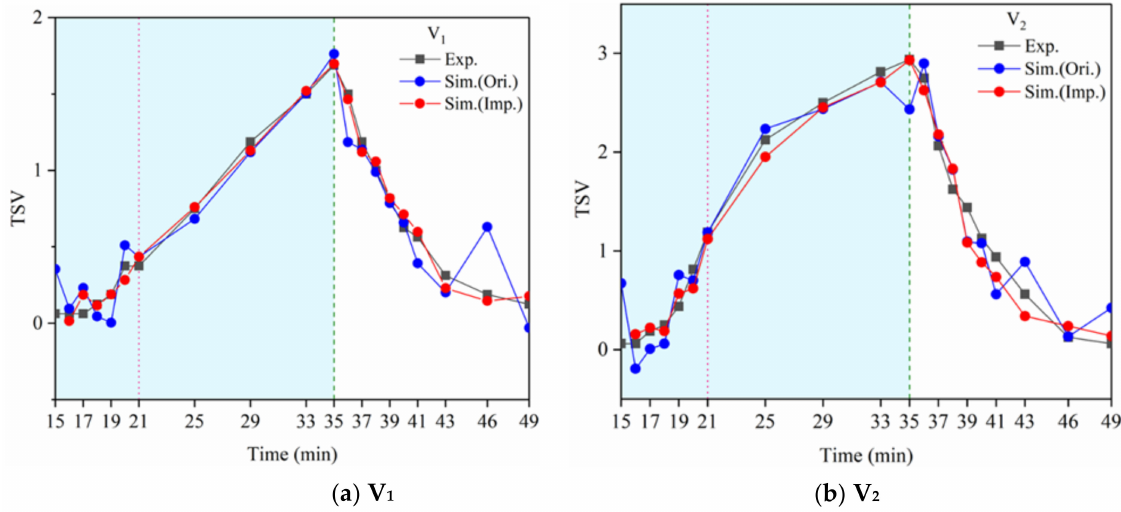
Figure 14. Comparison of the model simulation